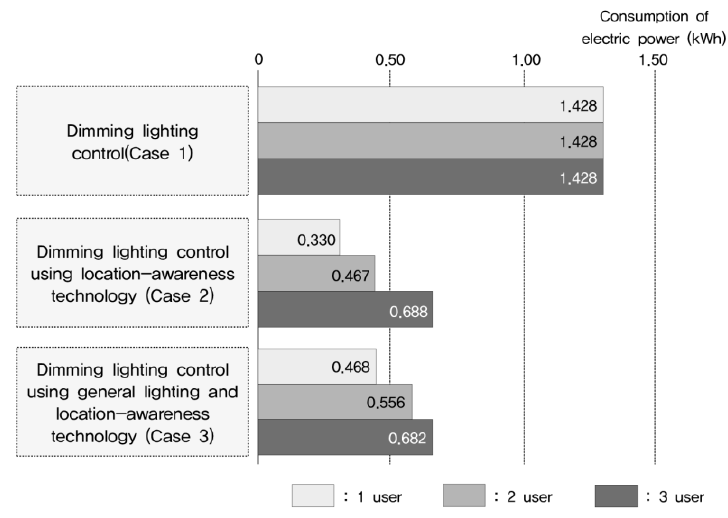
Figure 6. Consumption of electric power according to the lighting control method.